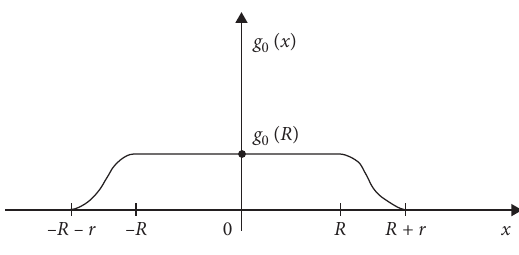
Figure 1: The amplitude profile